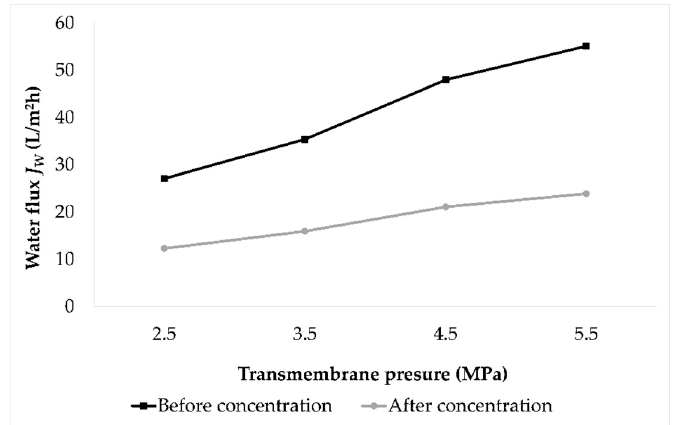
Figure 3. Water fluxes J W (L/m 2 h) before and after concentration of conventional and ecological Cabernet Sauvignon red wines by reverse osmosis measured at 2.5, 3.5, 4.5, and 5.5 MPa at 25 °C. Table 2. Fouling index (%) of reverse osmosis membranes at four different pressures. Pressure (MPa)